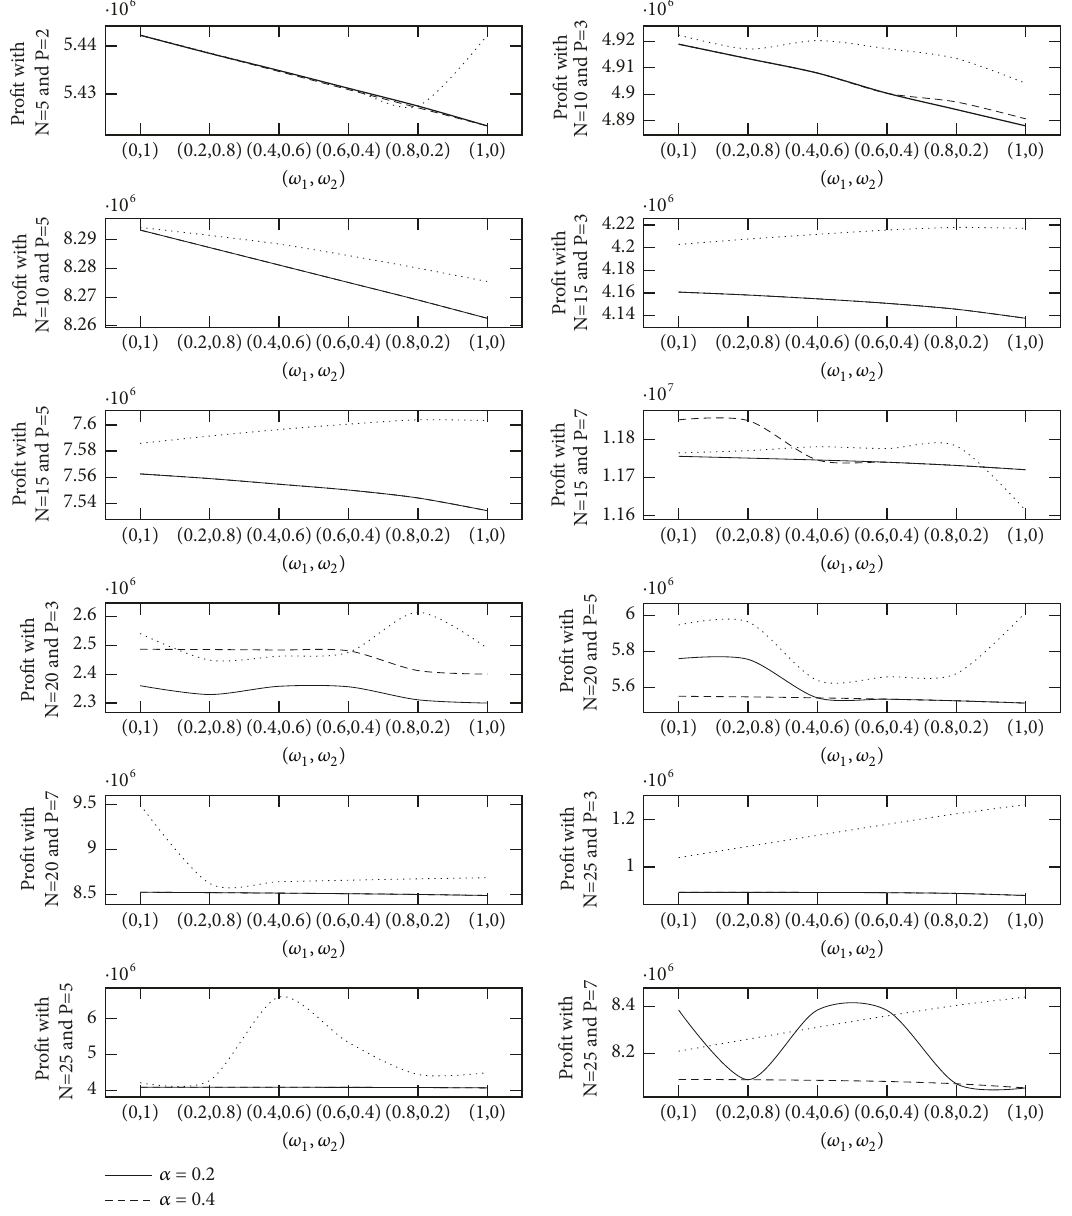
Figure 2: Profits comparison under different parameter